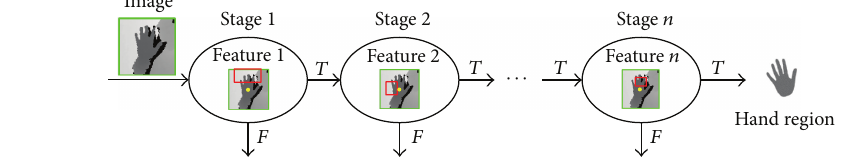
Figure 4: Method for calculating the threshold.